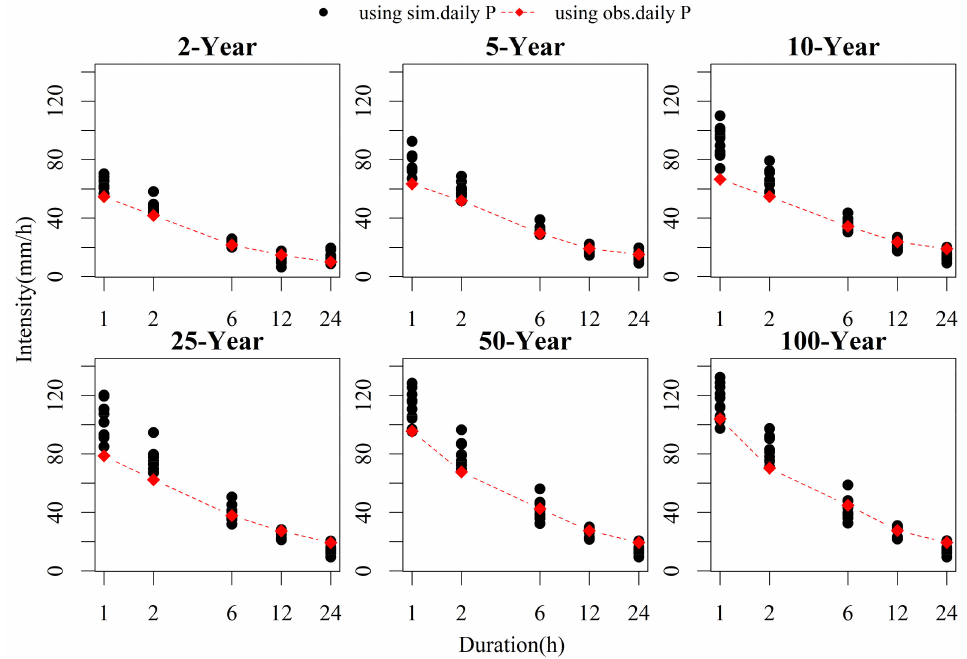
Figure 3. Intensity-Duration-Frequency (IDF) curves from the k-NN method using both the simulated and observed daily precipitation of Tainan in the historical period